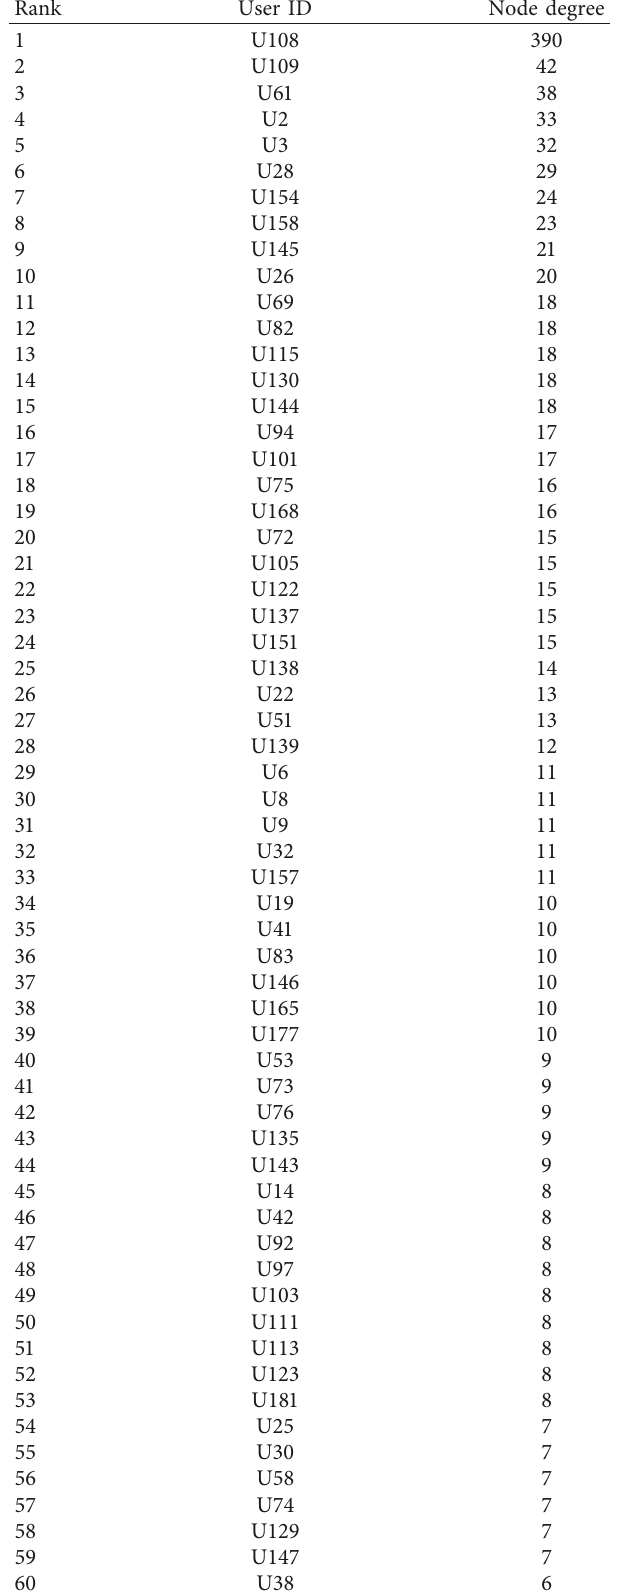
Table 4: The users with top 60 node degree in co-creation user